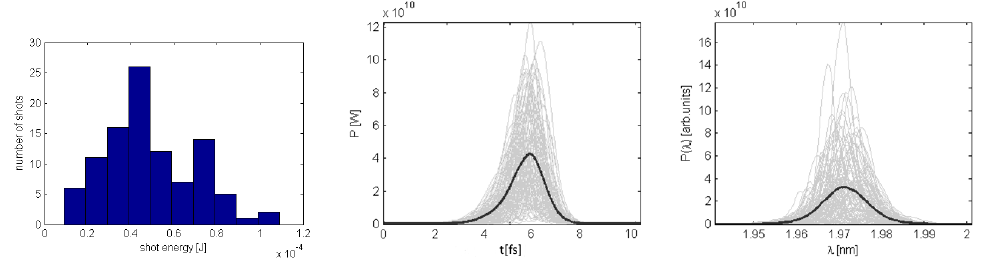
Figure 6. Radiation properties from U1 tuned at the fundamental photon energy of 630 eV: distribution of FEL shots with different energies per pulse (left subfigure), power along the FEL pulses (middle) and their spectra (right). The mean energy per pulse is 50 µ J (5 × 10 11 photons) and the mean pulse duration is about 1.5 fs